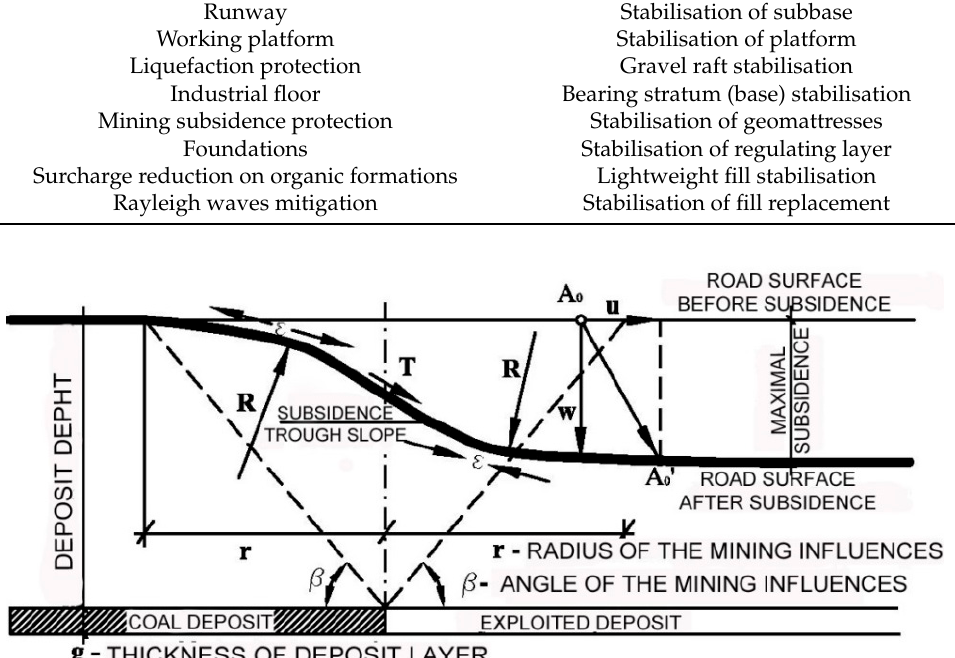
Figure 20. Influence from mining activity on road pavement [44].